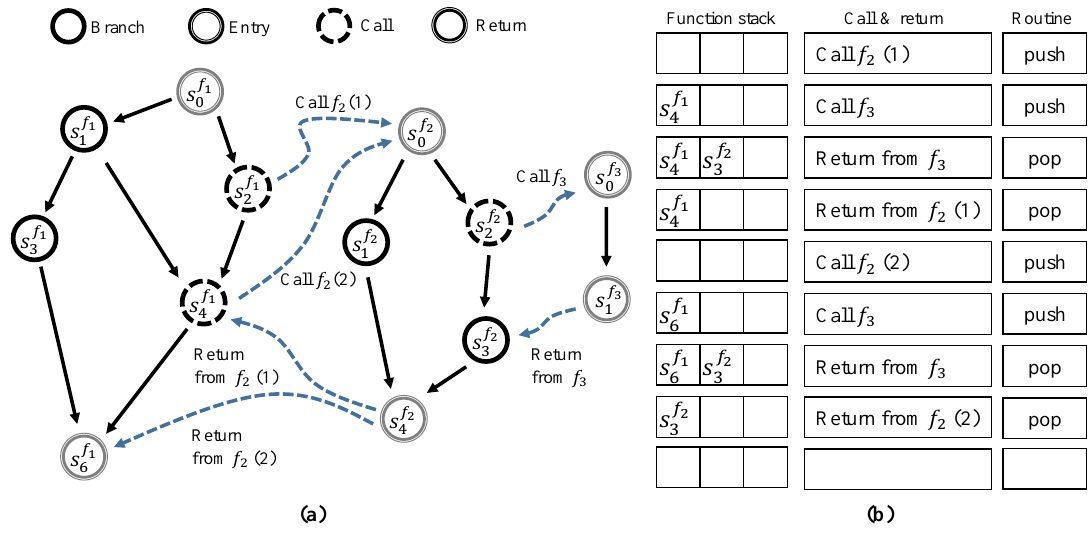
Figure 6. ( a ) Inter-procedural CFG; and ( b ) function stack